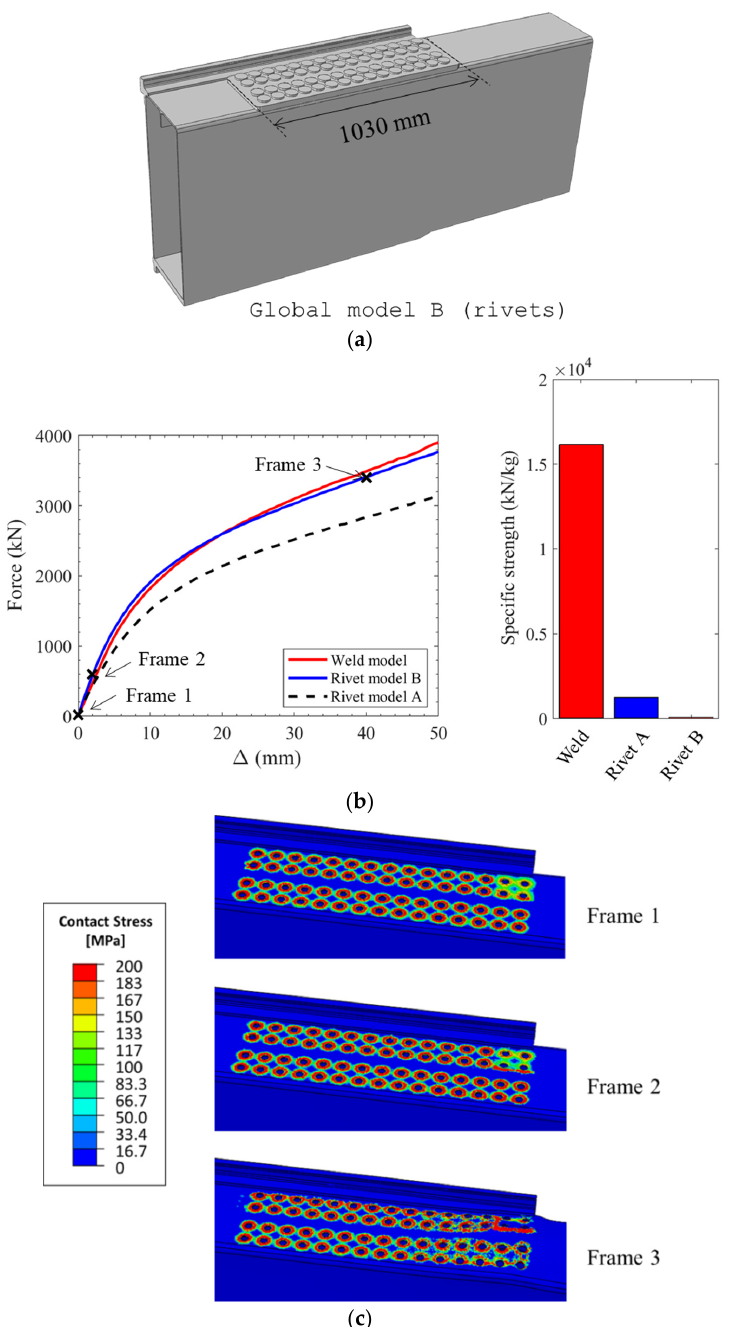
Figure 13. ( a ) Global model of the extended riveted joint, ( b ) force vs. displacement response and specific strength, and ( c ) contour plot of contact stress.